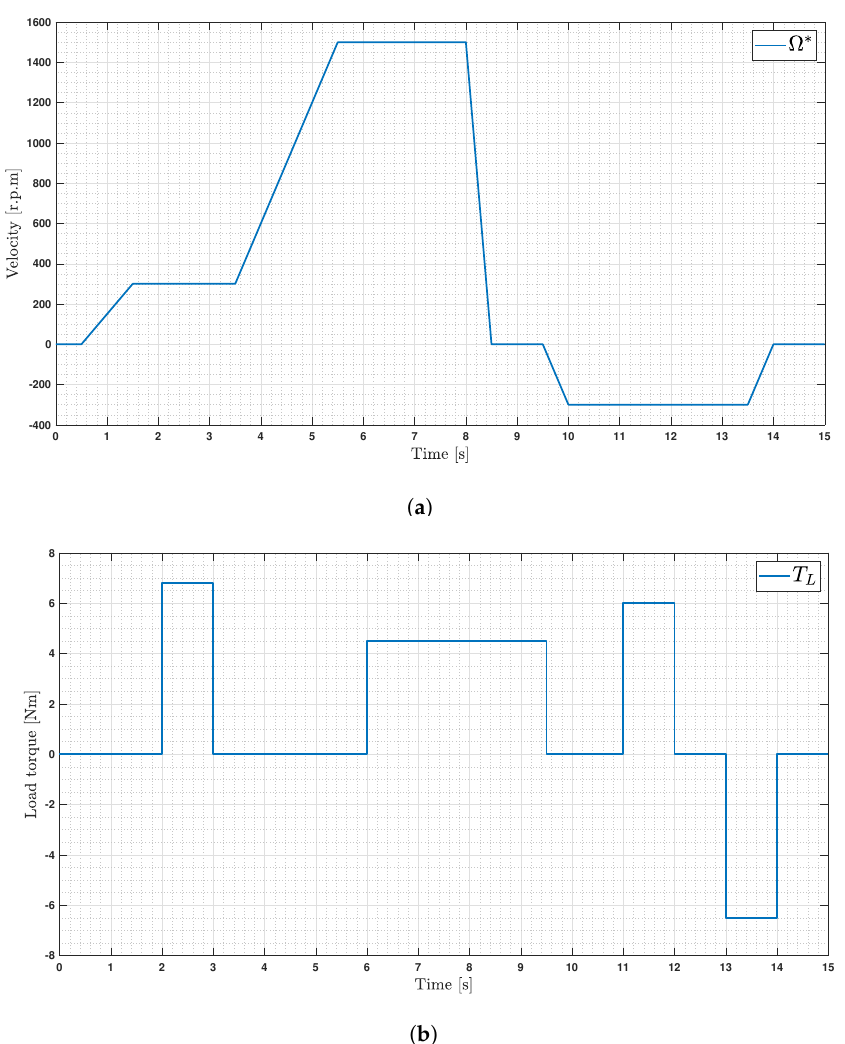
Figure 5. Reference velocity and load torque profiles applied in the simulation: ( a ) reference velocity profile and ( b ) load torque